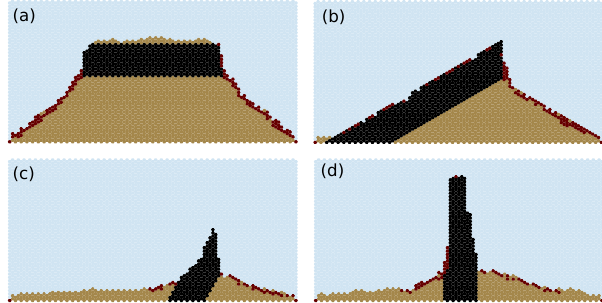
Figure 18. Examples of models that include blocks. Rock (black) weathers to blocks (dark red), which can only move downward or downward plus laterally. Blocks in turn weather to regolith (light brown) (GIF-format animations of similar runs are available as an online resource; see Tucker,